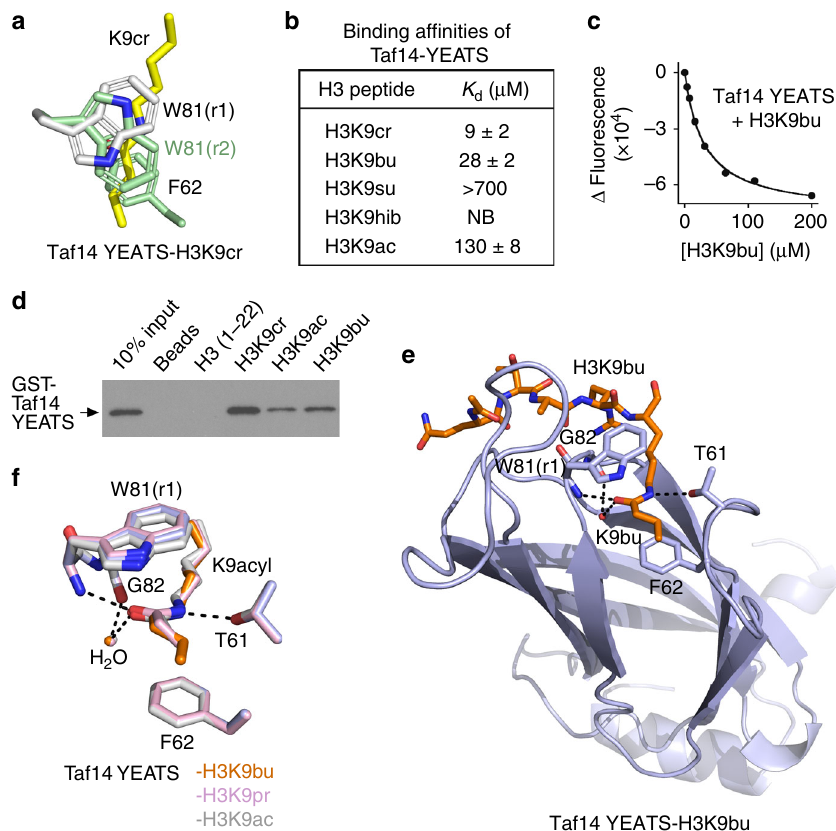
Fig. 1 Structural insight into the selectivity of Taf14-YEATS. a Crotonylated lysine (yellow) is sandwiched between W81 and F62 in the complex of Taf14- YEATS with H3K9cr. W81 adopts two conformations, rotamer 1 (light gray) and rotamer 2 (green). b Binding af fi nities of Taf14-YEATS to the indicated histone peptides, as measured by fl uorescence (cr, bu, ac) or NMR (su, hib). Values represent the average of three separate experiments (two for H3K9ac) with error calculated as the SD between the runs. The enhancement in selectivity of Taf14-YEATS to crotonyllysine is comparable to the enhancement in selectivity of other well-recognized epigenetic readers, such as DPFs 8,11 . c Representative binding curves used to determine K d by tryptophan fl uorescence. d Peptide pulldown assays for Taf14-YEATS using indicated histone H3 peptides. e The ribbon diagram of the Taf14-YEATS:H3K9bu complex. Dashed lines and red sphere represent hydrogen bonds and a water molecule, respectively. The YEATS domain is colored lavender and H3K9bu peptide is colored orange. Residues of the YEATS domain involved in the binding of K9bu are labeled. f Structural overlay of the acyllysine binding sites in the Taf14-YEATS: H3K9bu (lavender/orange), Taf14-YEATS:H3K9pr (pink), and Taf14-YEATS:H3K9ac 14 (gray)